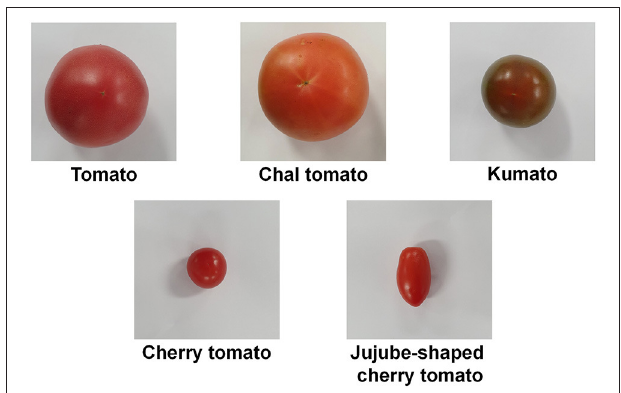
FIGURE 1 | Photographs of five types of